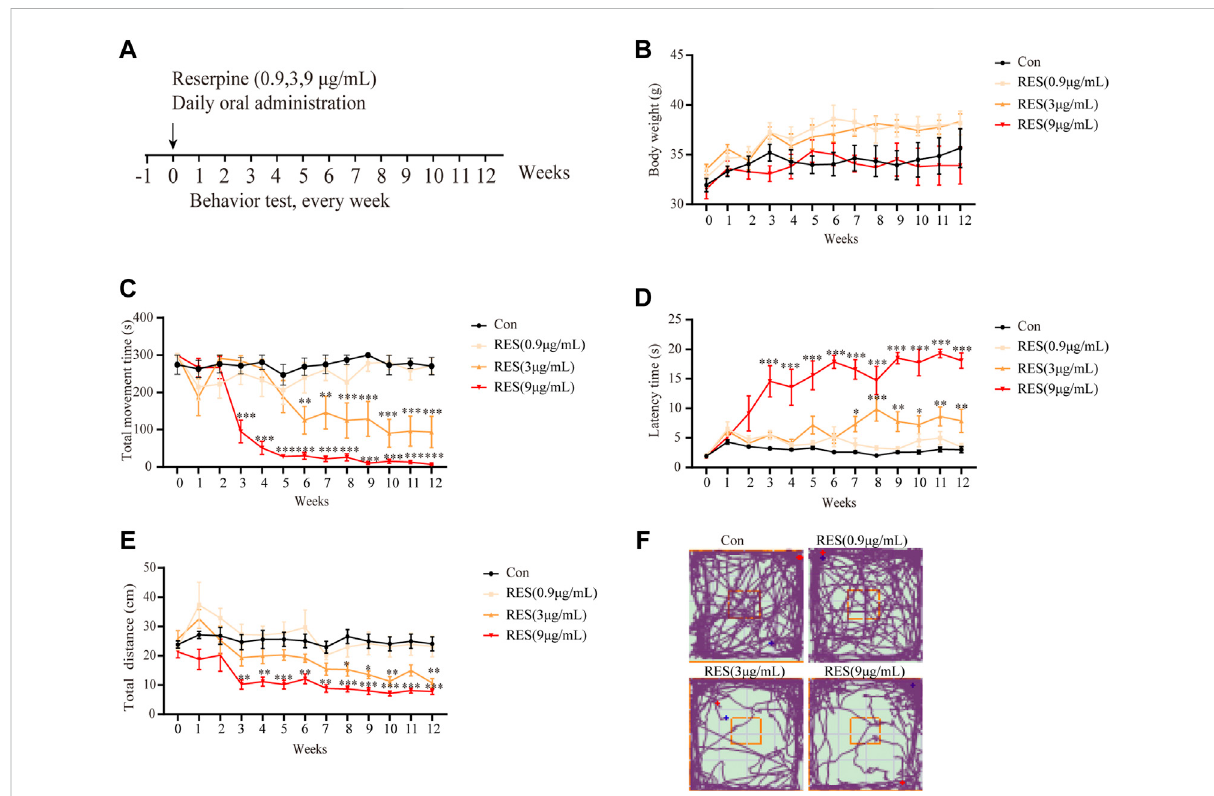
FIGURE 5 ReserpineinducedPD-likemotorsymptomsinmice. (A) Flowchartoftheexperimentaldesign. (B) Changesinbodyweightsofmiceinducedby different doses of reserpine ( n = 7 for each group, two-way ANOVA with Tukey ’ s post hoc test). (C) The movement time of mice decreased upon induction with different doses of reserpine in the rotarod test ( n = 7 for each group, two-way ANOVA with Tukey ’ s post hoc test, ** p < 0.01, *** p < 0.001 vs. control). (D) The latency time of mice increased upon induction with different doses of reserpine in the pole-climbing test ( n = 7 for each group, two-way ANOVA with Tukey ’ s post hoc test, * p < 0.05, ** p < 0.01, *** p < 0.001 vs. control). (E) Moved distances reduced in the open- fi eld test upon induction with different doses of reserpine ( n = 7 for each group, two-way ANOVA with Tukey ’ s post hoc test, * p < 0.05, ** p < 0.01, *** p < 0.001 vs. control). (F) Representative plots for the movement trajectory. All data are presented as mean ± SEM; Con, control; RES,